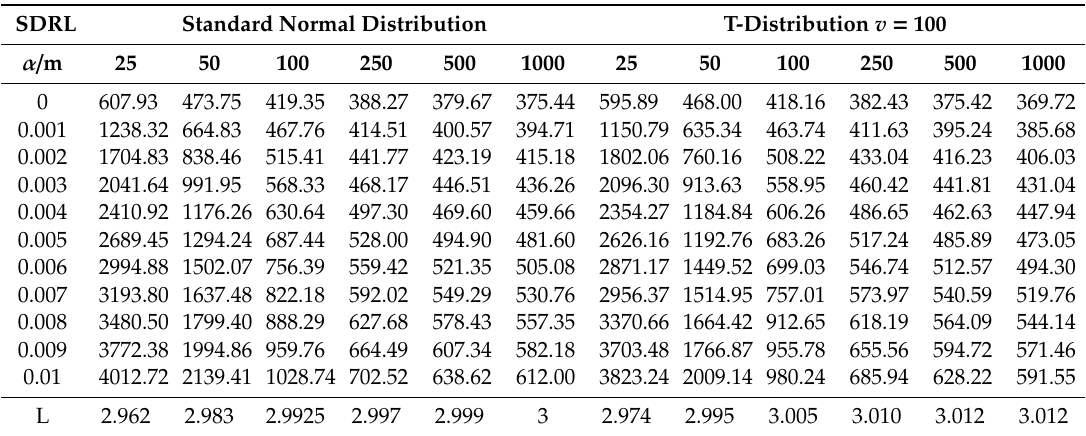
Table 4. SDRL of the Shewhart chart in the presence of outliers with estimated parameters for standard normal and t ( v = 100)